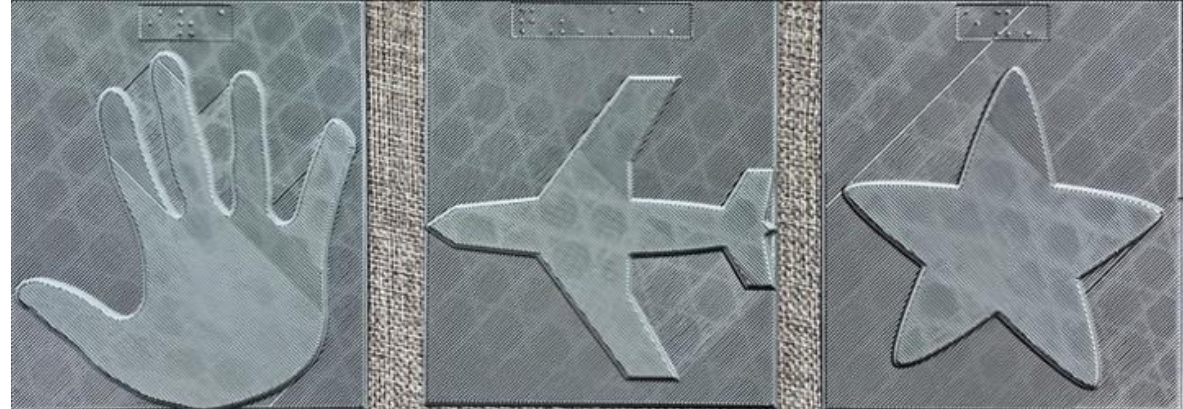
Figure 5. Samples of the tactile flashcards generated and 3D printed: (from left to right) hand, airplane, and star in English Braille.